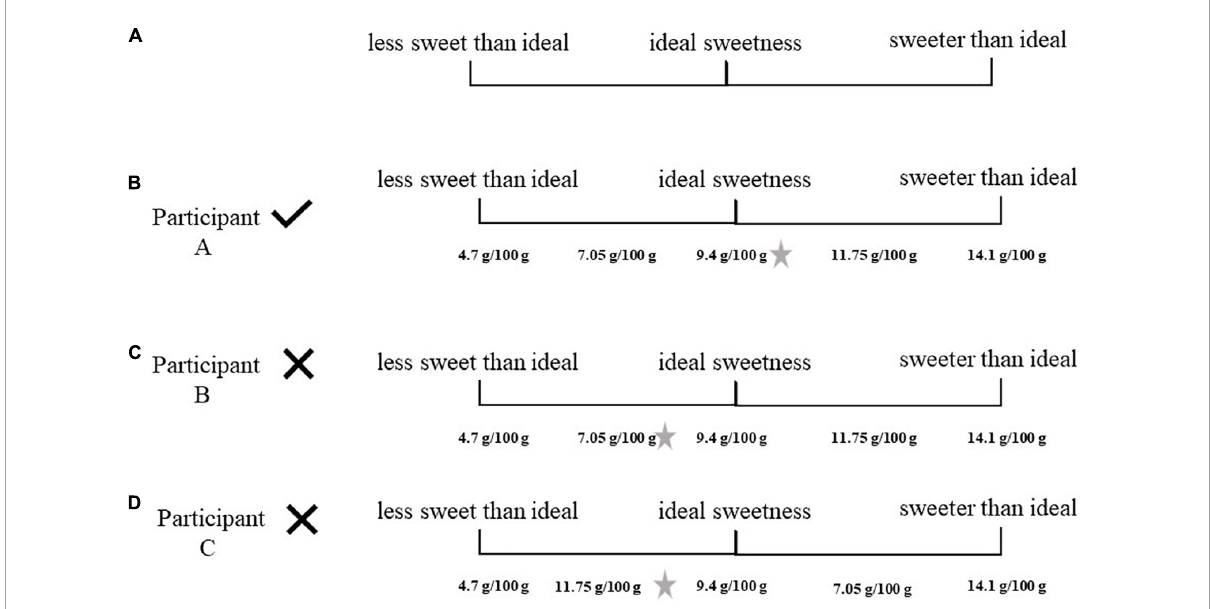
FIGURE1 (A) Participant selection form. (B) Participant selection form from a selected participant. (C) Participant selection form from a discarded participant. (D) Participant selection form from a discarded participant. The star placed on the right side illustrates participant preferred sample. In the original form, the volunteer marked the sample number on the scale. For didactic purposes, these codes were replaced with the sample concentration in the figure.